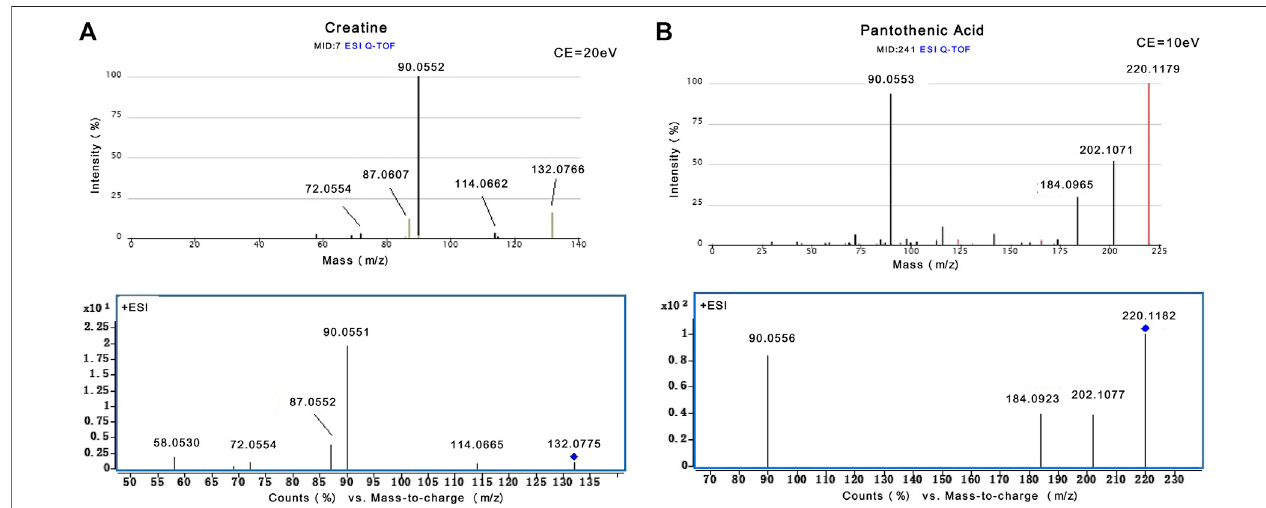
FIGURE5| Theidenti fi cation ofcreatine andpantothenicacid. (A) MS/MSspectraofcreatinefromMetlindatabase and actualcollection (m/z132.08). (B) MS/MS spectra of pantothenic acid from Metlin database and actual collection (m/z 220.12).